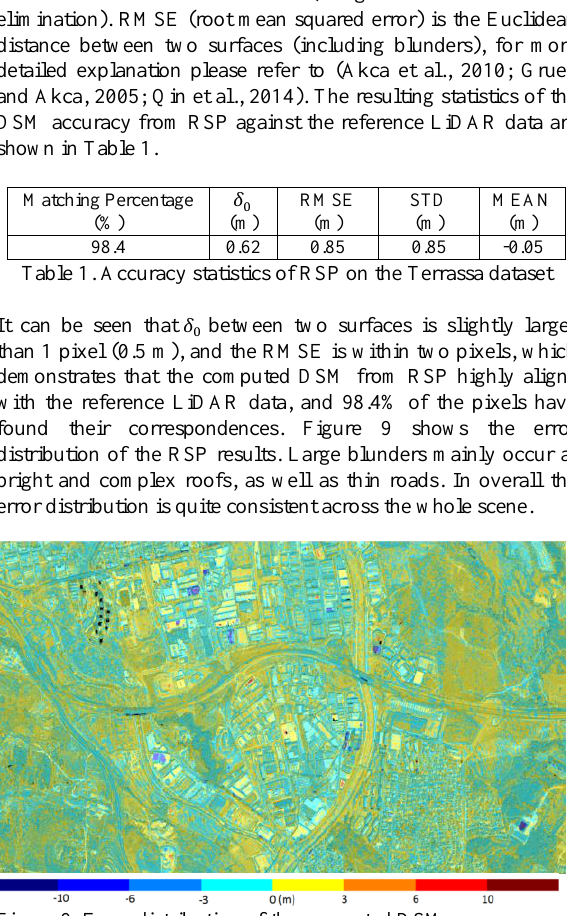
Figure 9. Error distribution of the computed